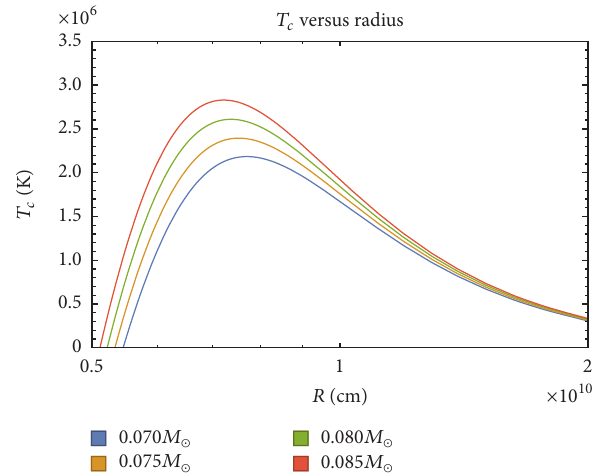
Figure 1: The variation of 𝑇 𝑐 versus radius 𝑅 for different masses.